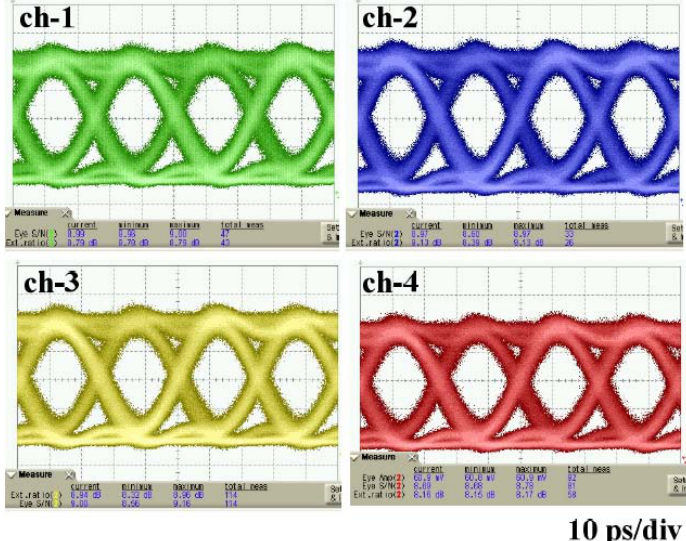
Figure 14. 40 Gb/s electrical eye diagrams obtained for the four channels at the output of the demultiplexer.